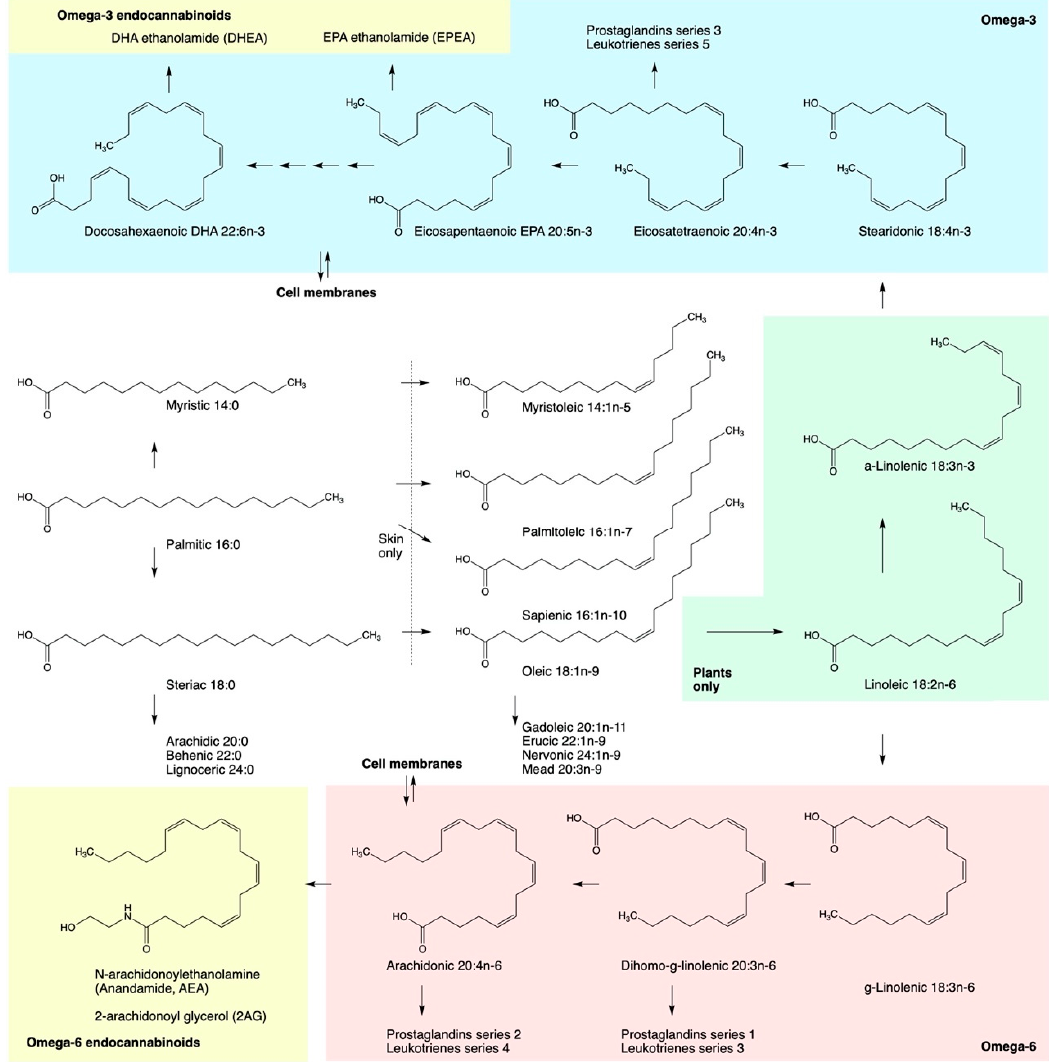
Figure 1. Pathways in the biosynthesis of polyunsaturated fatty acids including n-6 and n-3 essential fatty acids precursors, eicosanoid family metabolites, and endocannabinoids.